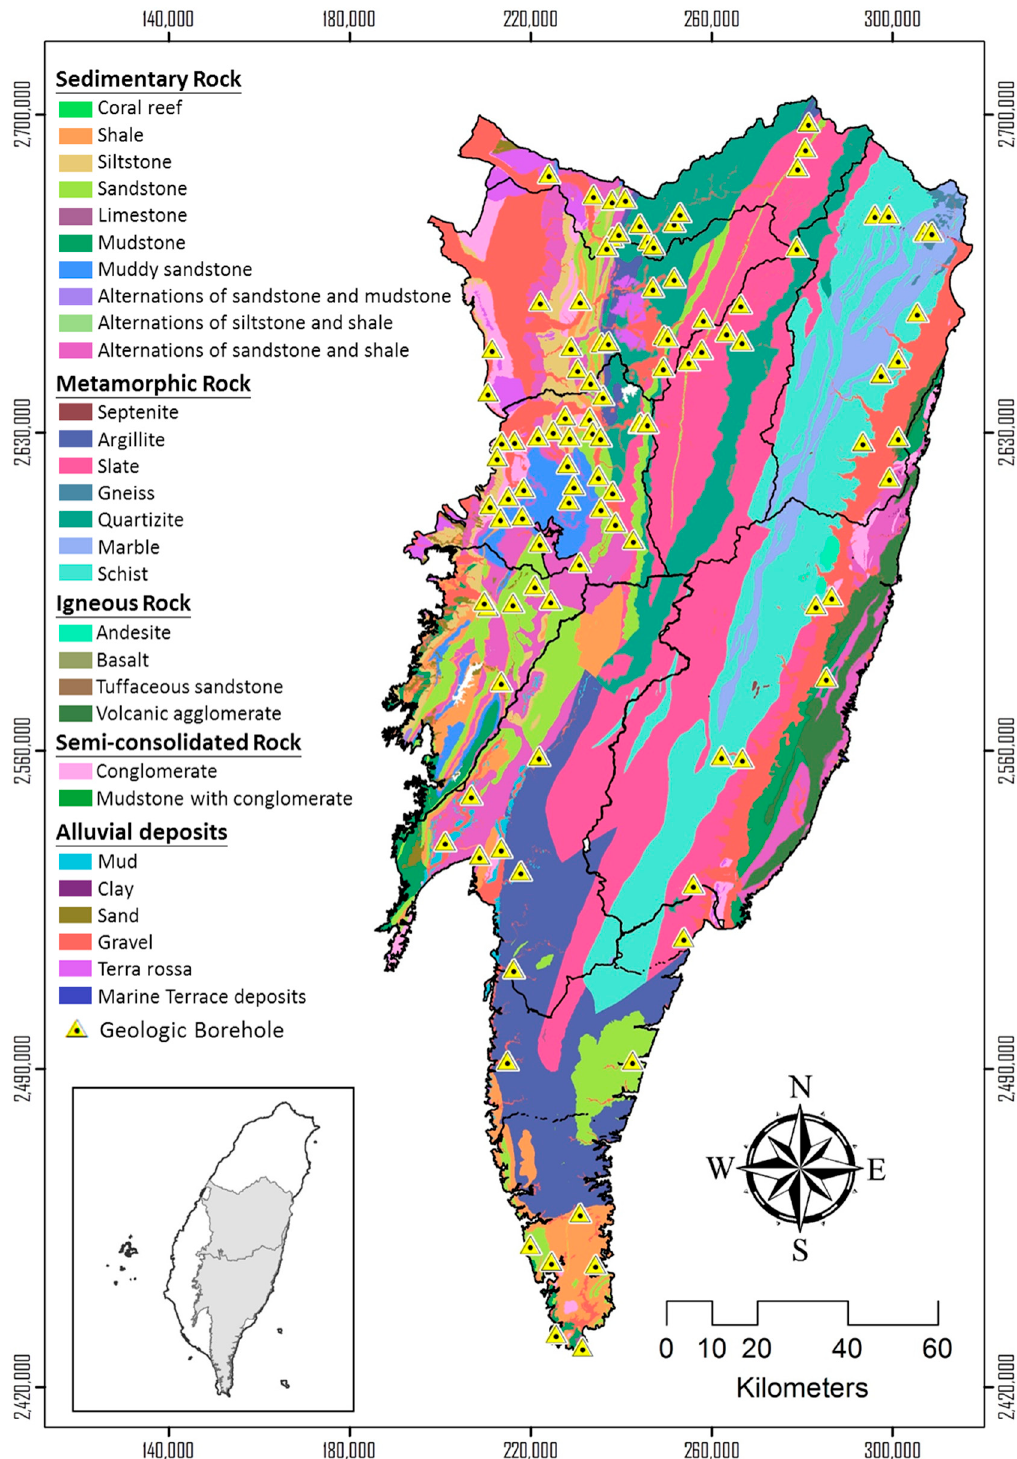
Figure 1. Locations of the study area and geologic boreholes [30,31,53].